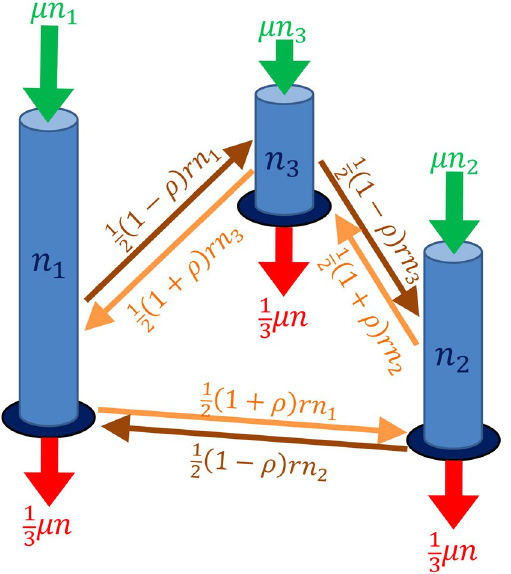
Figure 1. Illustration of the dynamics. Bars (blue) represent populations at each of the three nodes of the network. Small arrows correspond to migration rates of particles between nodes. Large arrows depict the rate of births and deaths of particles at each